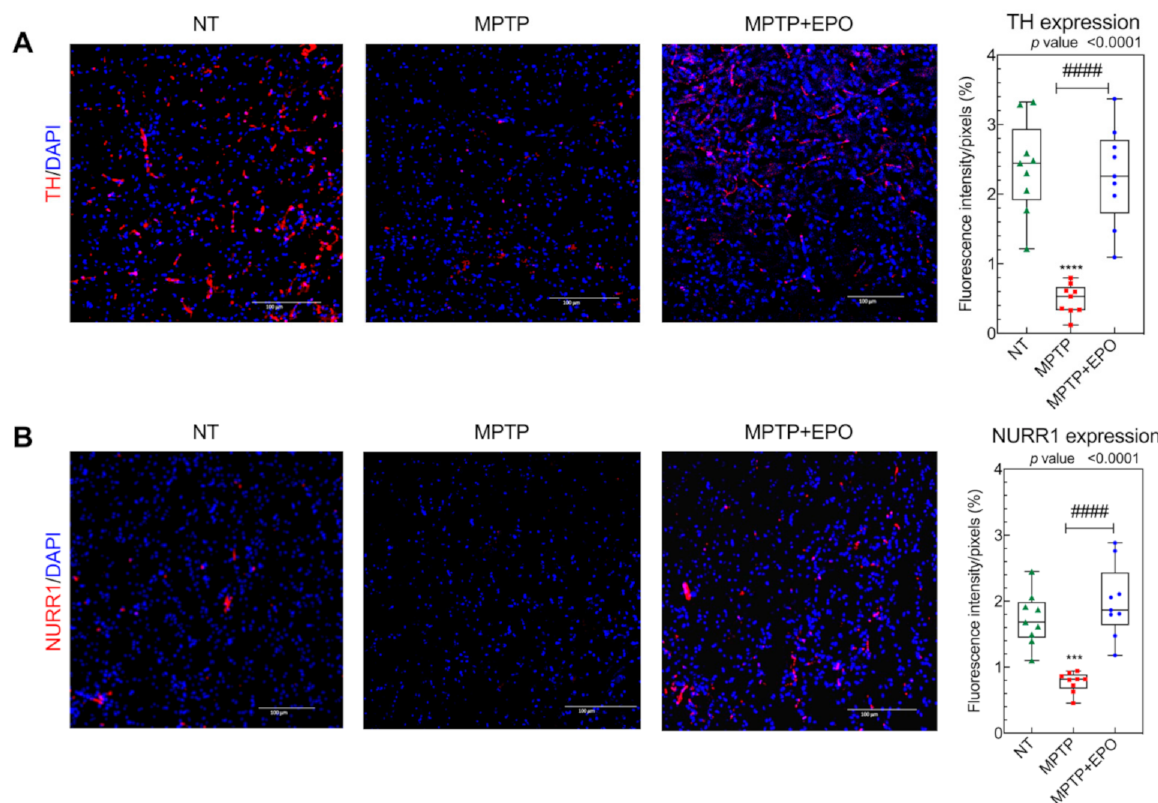
Figure 8. In vivo recovery of dopaminergic targets TH and NURR1. TH ( A ) and NURR1 ( B ) expression in the striatum was studied via immunofluorescence (see Section 2) in non-treated (NT), mice treated with MPTP (MPTP) and MPTP-treated mice after EPO injection (MPTP+EPO). Scale bar: 100 µ m. Data for immunofluorescence quantification are expressed as box and whisker plot of 3 animals for each condition ( n = 3 mice each condition; 3 slides per mouse; 2 images per slide) and results are represented as mean of optical density/pixels. *** p < 0.001 **** p < 0.0001 vs. NT; #### p < 0.0001 vs. MPTP). Fluorescence quantification was performed with the software Image-J